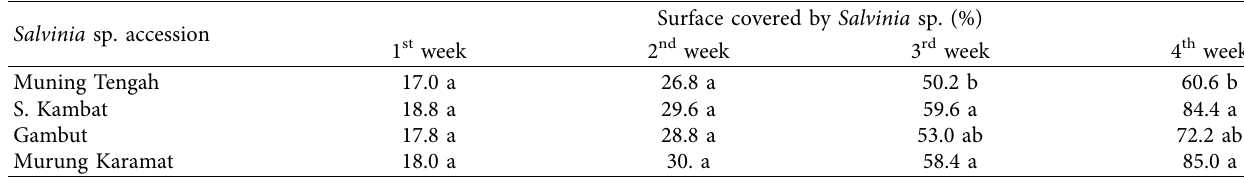
Table 7: The percentage of surface covered by Salvinia sp. after 4 weeks of maintenance in tidal swampland soil growing media. Salvinia sp. accession